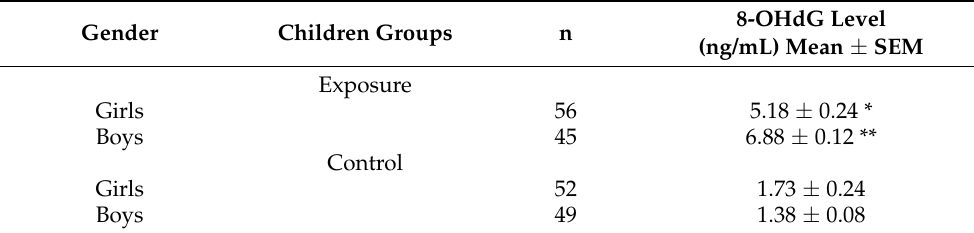
Table 5. Means of urinary 8OHdG (ng/mL) levels by gender in the (El Fraile, Taxco de Alarc ó n)- exposure and (Chilpancingo)-control groups, in Guerrero State,